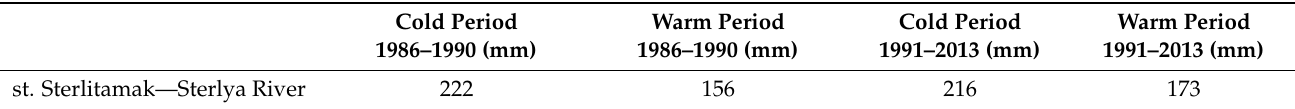
Table 5. Effective precipitation (>10 mm/day) dynamics in the Sterlya river